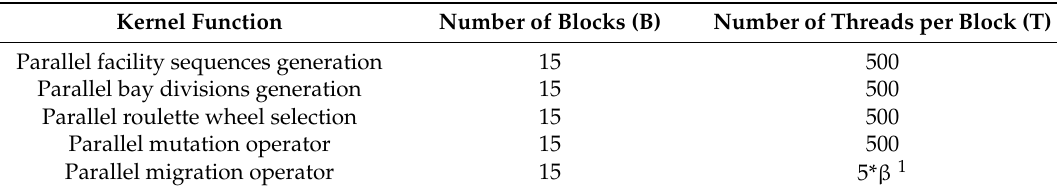
Table 5. Configuration of each kernel function.